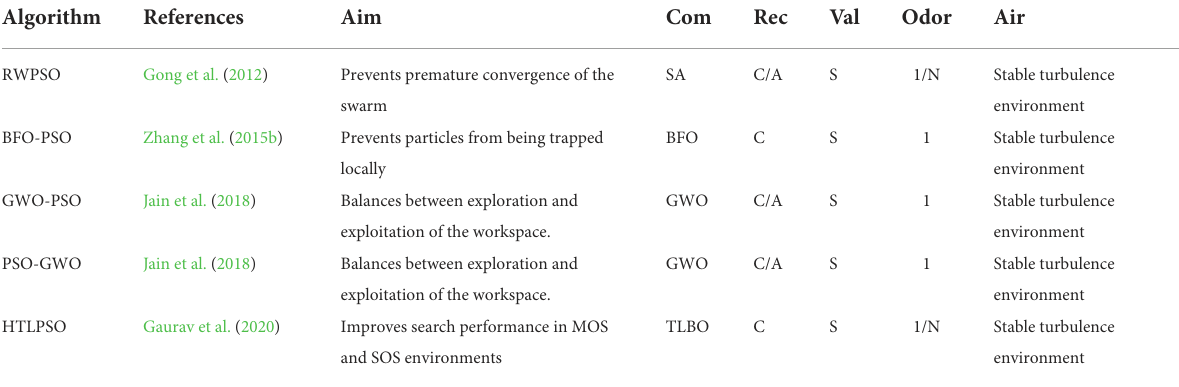
TABLE 2 Summary of the hybrid PSOs for odor source localization.